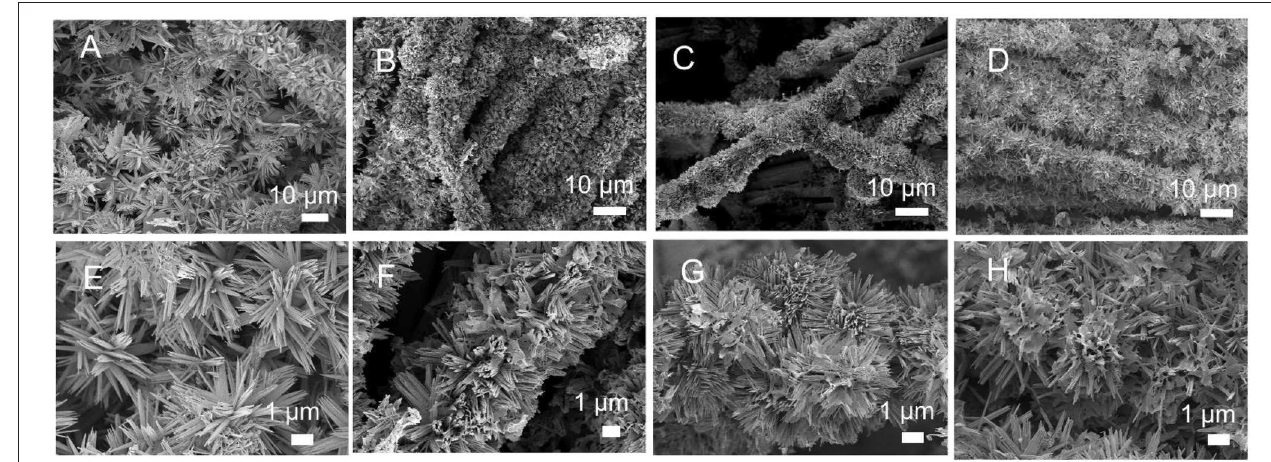
FIGURE 2 | SEM images for CuCo 2 S 4 /CC at different reaction times: 2h (A,E) ; 4h (B,F) ; 6h (C,G) , and 8h (D,H) .